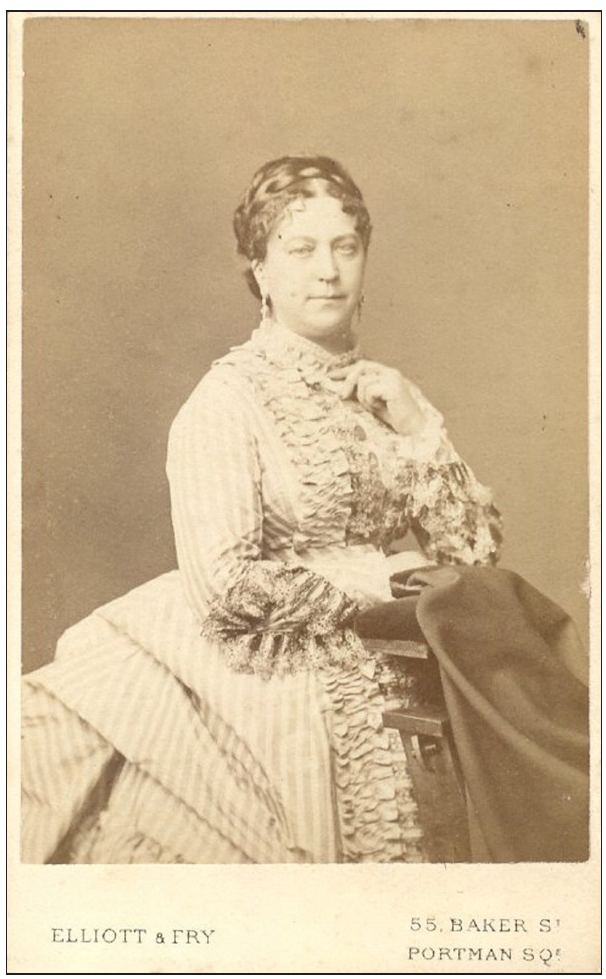
Fig. 2 : Lady Wallace, Carte de visite photograph by Elliott & Fry, c. late